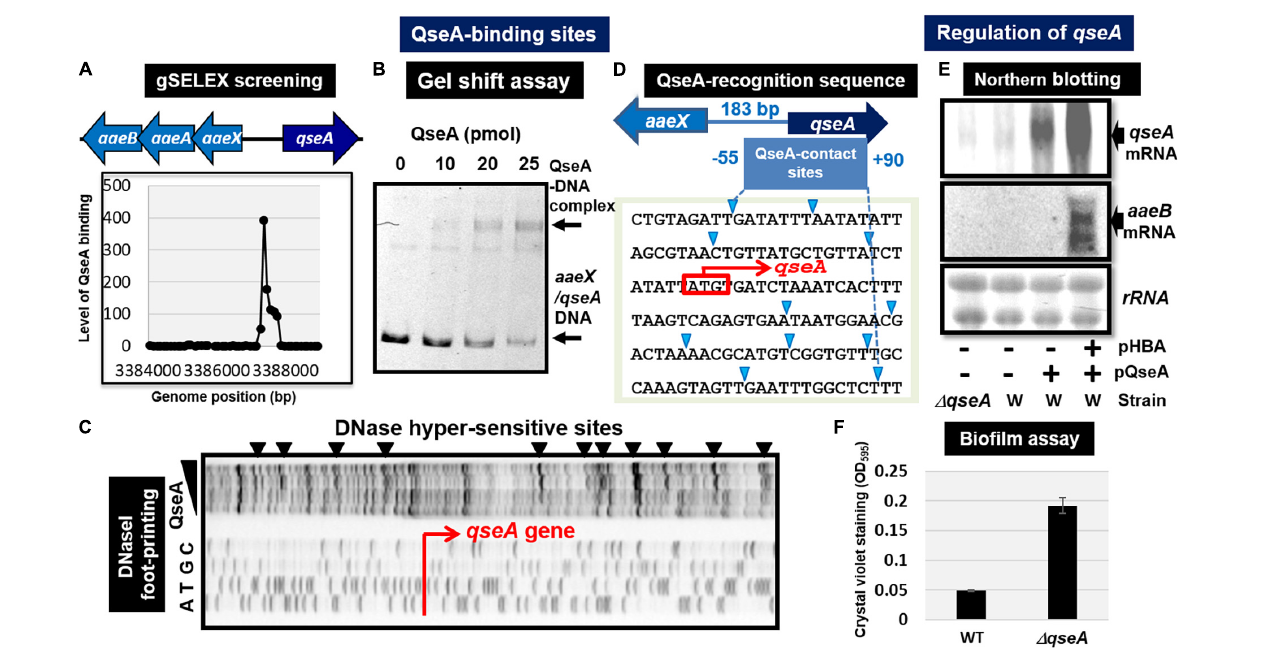
FIGURE 4 | Functional analysis of QseA. (A) Expanded gSELEX pattern of QseA. gSELEX pattern is expanded to show the QseA-binding level near the single major peak inside the spacer between aaeXAB and qseA . (B) Gel shift assay of QseA. (C) DNase-I footprinting of the QseA-binding sequence above the qseA promoter region. DNase-I hypersensitive sites are indicated by triangles along the promoter sequence. (D) QseA recognition sequence determined by DNase-I footprinting. DNase-I hypersensitive sites are indicated by triangles (shown in blue). (E) Northern blot analysis of qseA and aaeB mRNAs. RNA was isolated from wild-type and qseA -deletion mutant E. coli K-12 grown in the presence and absence of pHBA. RNA was subjected to Northern blot analysis using the qseA and aaeB probes. The amounts of QseA target mRNAs were measured as relative levels of 23S and 16S rRNAs stained with methylene blue. (F) Biofilm assay of wild-type and qseA -deletion mutant using crystal violet staining